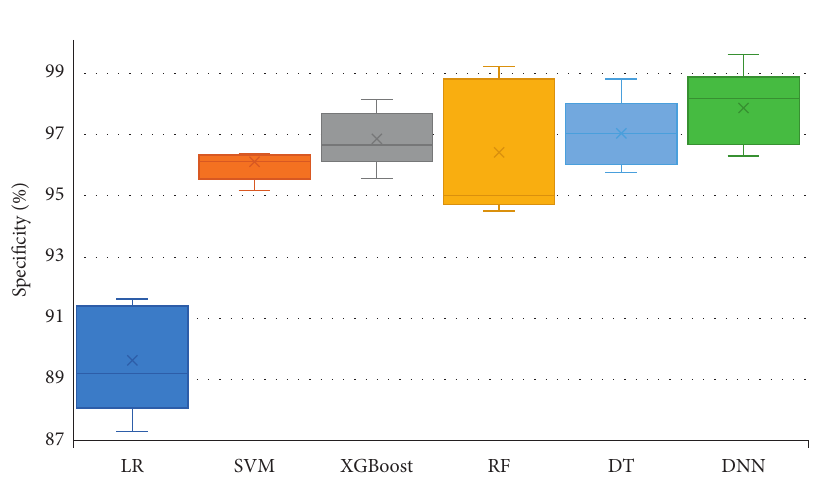
Figure 10: Performance comparison of classifiers based on